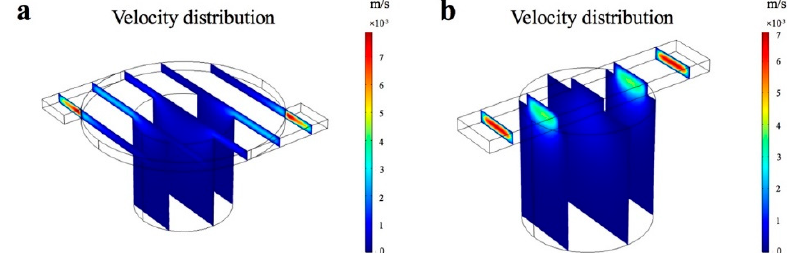
Figure 3. The simulation of velocity distribution in slice field. ( a ) Flanged chamber with 2 mm diameter round structure connected to the chamber. ( b ) Straight channel connected to the culture chamber.